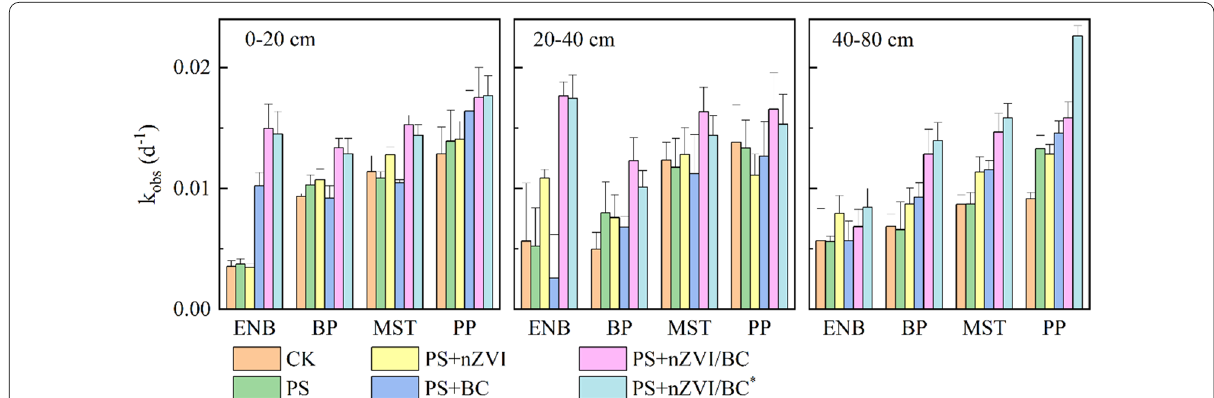
Fig. 3 The observed pseudo-first-order degradation rates of contaminants with different treatments in the remediation. PS: 0.2 g kg − 1 ; BC: 0.1 g kg − 1 ; nZVI: 0.1 g kg − 1 ; nZVI/BC: 0.2 g kg − 1 ; nZVI/BC*: 0.5 g kg −